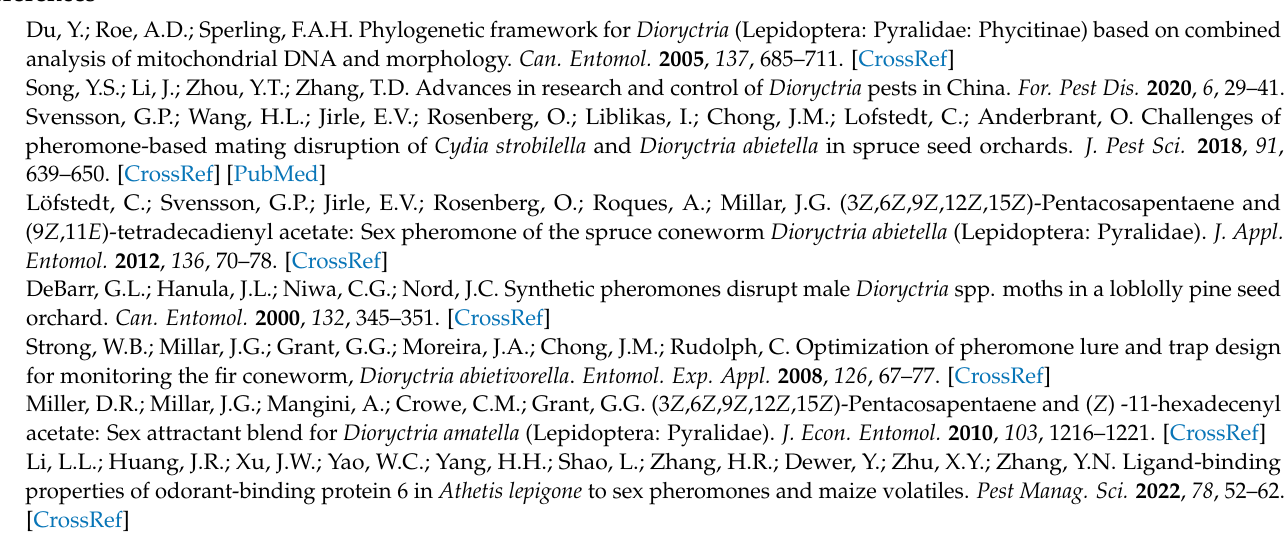
Table S2: Binding affinities of two D. abietella OBPs to various